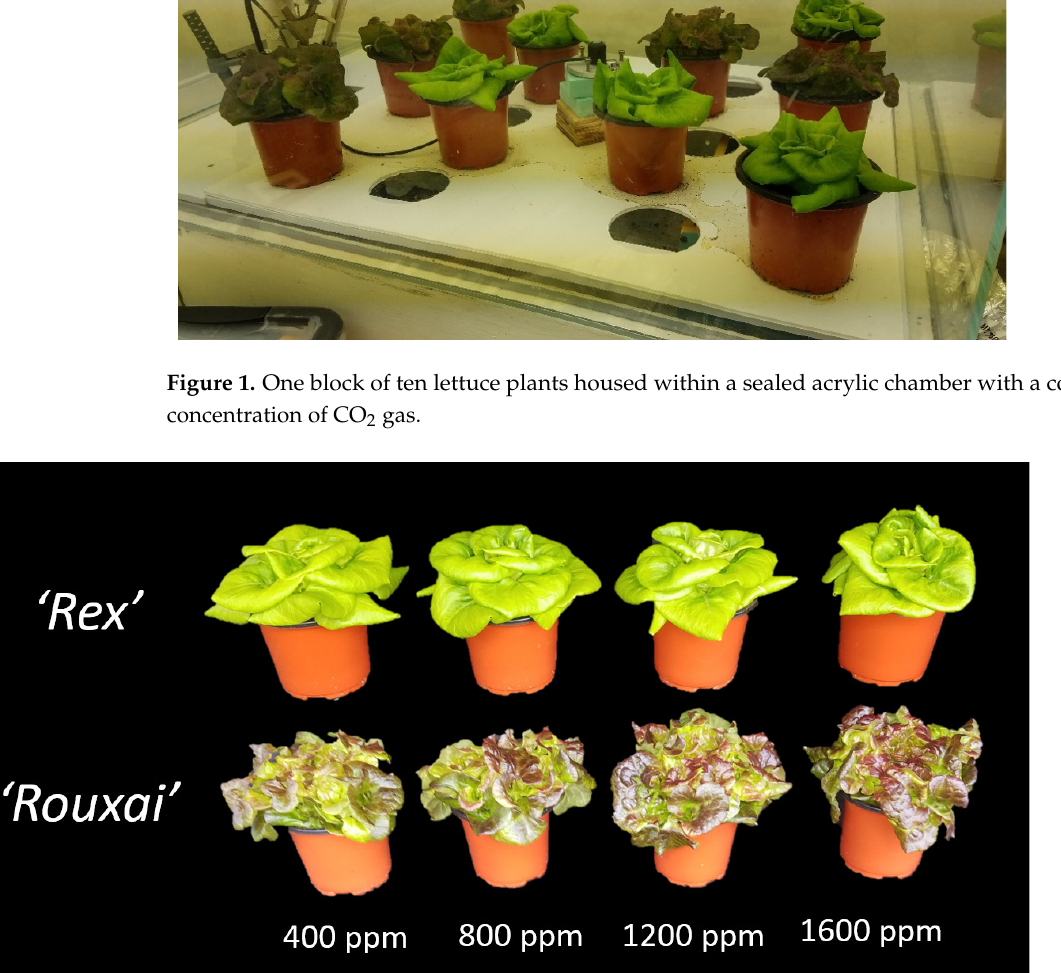
Figure 1. One block of ten lettuce plants housed within a sealed acrylic chamber with a controlled concentration of CO 2 gas.